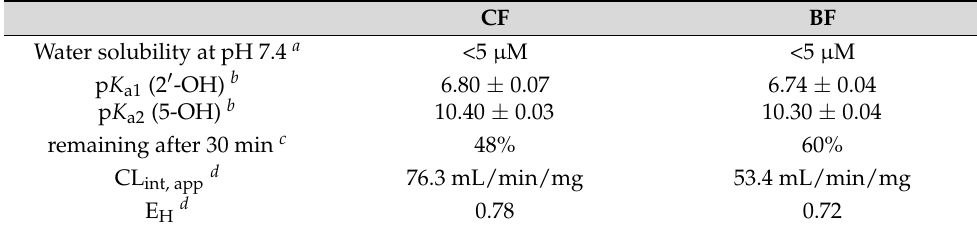
Table 2. Determination of physicochemical properties .